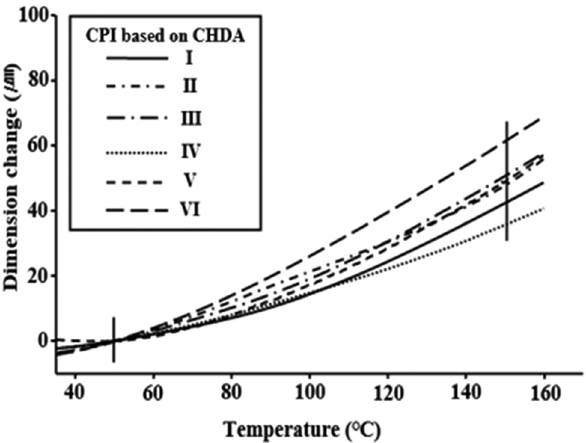
Figure 7: TMA thermograms of the CPI fi lms obtained from the CHDA